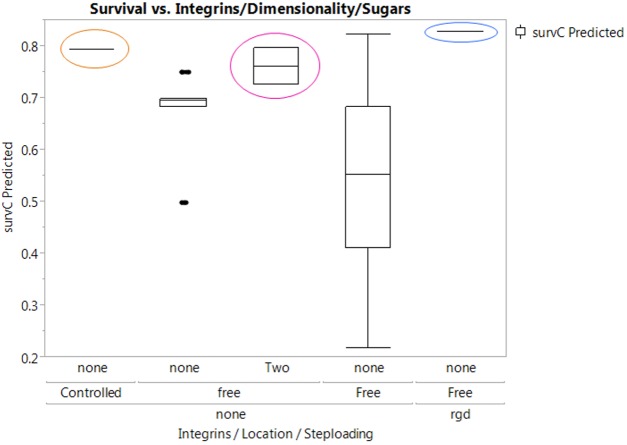
A summary scatter-plot analysis of key values for meta-data on main decision factors.A scatter plot matrix capturing the summary statistics for the meta-data collected from previous analyses used to develop a heuristic for predicting the posterior survival probabilities for cells for a given set of process decisions (Sambu et al., 2011; Heng, Yu & Ng, 2004; Kashuba Benson, Benson & Critser, 2008; Miszta-Lane et al., 2007). Key decision variable combinations with 100% “live” cells are framed in purple. The numbers on each axis represent the categories identified within a decision variable. Red dots represent short-living cells while green dots represent long-living cells.